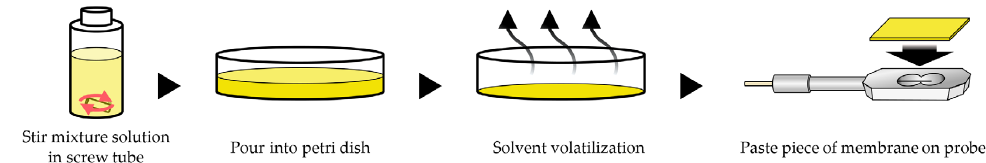
Figure 2. Fabrication of lipid/polymer membranes.